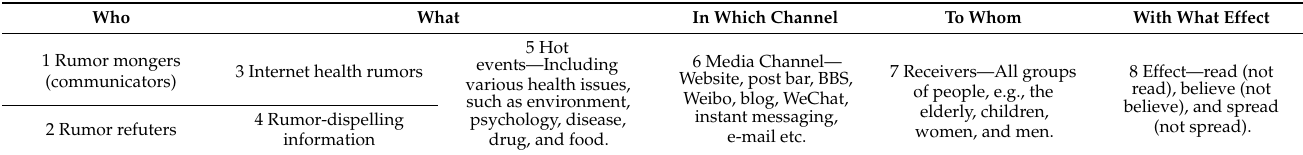
Table 5. Eight-element communication model for Internet health rumors.